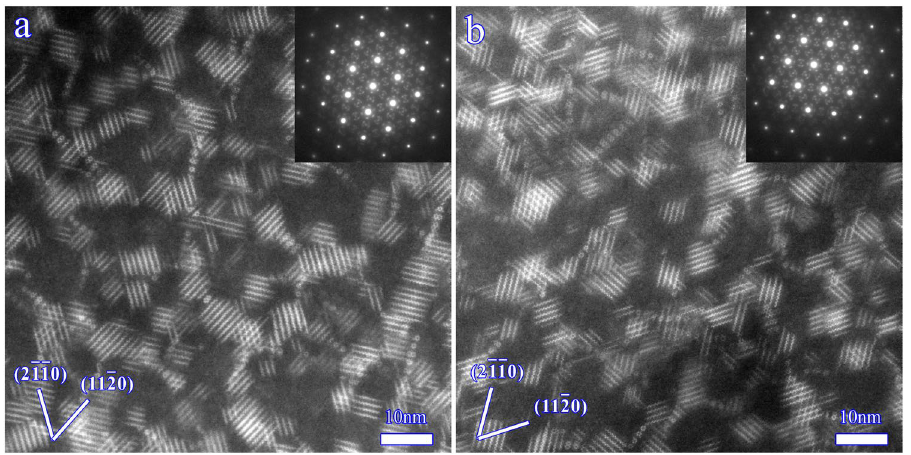
Figure 3. HAADF-STEM images showing the distribution and morphology of precipitates in peak aged condition in ( a ) AS sample and ( b ) PT sample. Electron beam is parallel to [0001] α